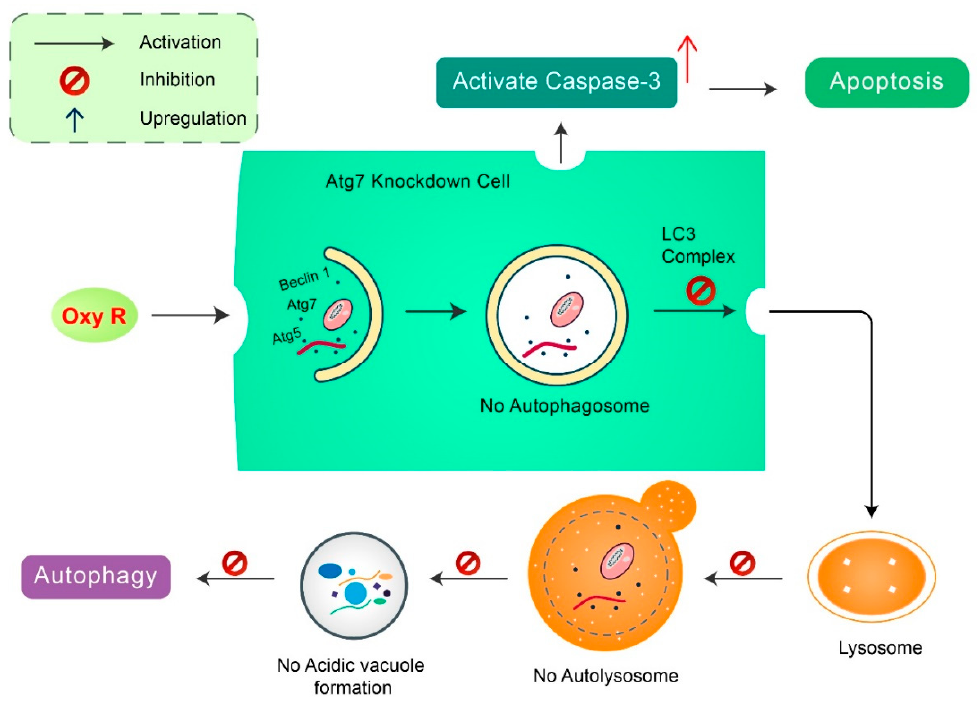
Figure 6. Natural compound oxyresveratrol (Oxy R) stimulates apoptosis and autophagy-dependent cell death. Oxy R activates autophagy through autophagy initiation Atg7 and Beclin 1 dependent pathways. Atg7 knockdown prevents autophagy, but activates apoptotic cell death in SH-SY5Y cells. Blockage of autophagy via 3-MA, Oxy R inhibits autophagic cell death. When apoptosis signaling is inhibited by Z-DEVD-FMK caspase-3 inhibitor, Oxy R exhibits autophagic cell death.